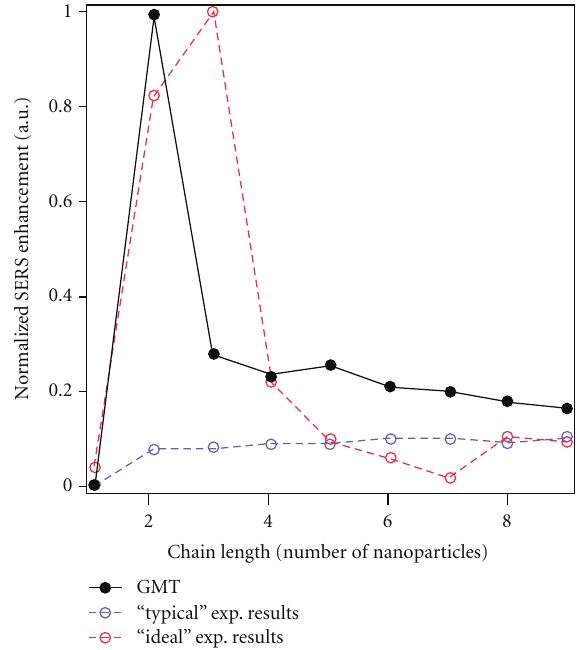
Figure 5: Black trace—generalized Mie theory calculations for the SERS EF for 60 nm diameter Au nanochains with a 1.5 nm interparticle separation, embedded in a medium with refractive index n e ff = 1 . 5. Blue trace—experimental SERS EF measurements for 60 nm diameter Au nanochains lying within one standard deviation from the average measured EF value for each chain length (i.e., “typical” results). Red trace—largest values for the SERS EF for each chain length measured in this experiment (i.e., “ideal” results). “Typical” results (blue trace) are normalized against the values for the “ideal” results (red trace) to illustrate the di ff erence in magnitude between the two experimental data